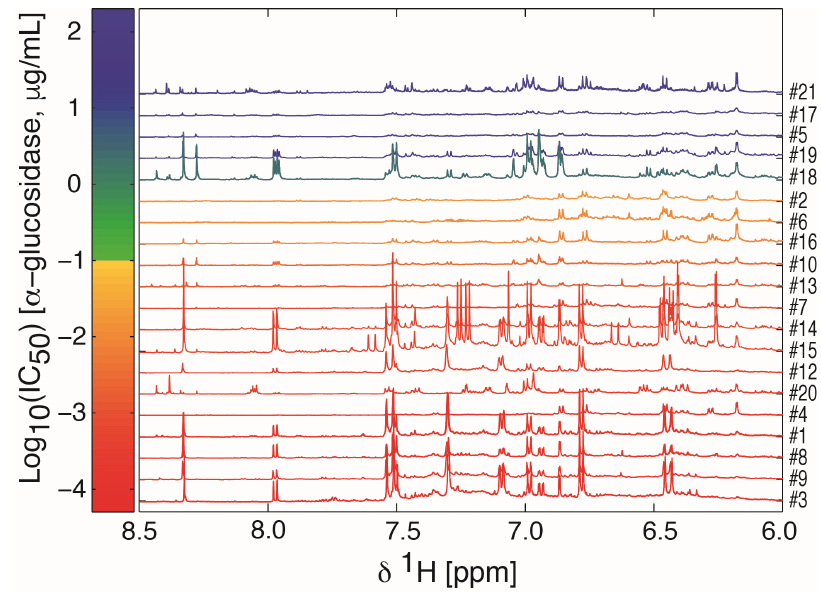
Figure 1. An expansion of 600 MHz 1 H-NMR spectra of ethyl acetate extracts of Radix Astragali samples dissolved in DMSO- d 6 . The color and order of the spectra reflects the activity in the α -glucosidase inhibition assay according to the bar to the left. The number to the right is the number of the samples according to Table 1. Active extracts are those with IC 50 values < 100 µ g/mL and extracts with low activity are those with IC 50 values ≥ 100 µ g/mL. The non-active extract #19 showed only 30% inhibition at 5 mg/mL, and the remaining non-active extracts were arbitrarily set to 10 mg/mL for plotting purposes. The full spectral range 0–9 ppm can be seen in Supplementary Materials, Figure S3.